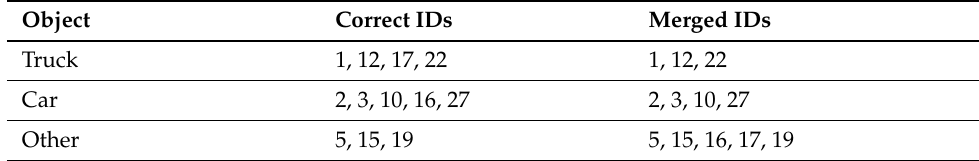
Table 9. Pipeline tracking profiles with and without the correction